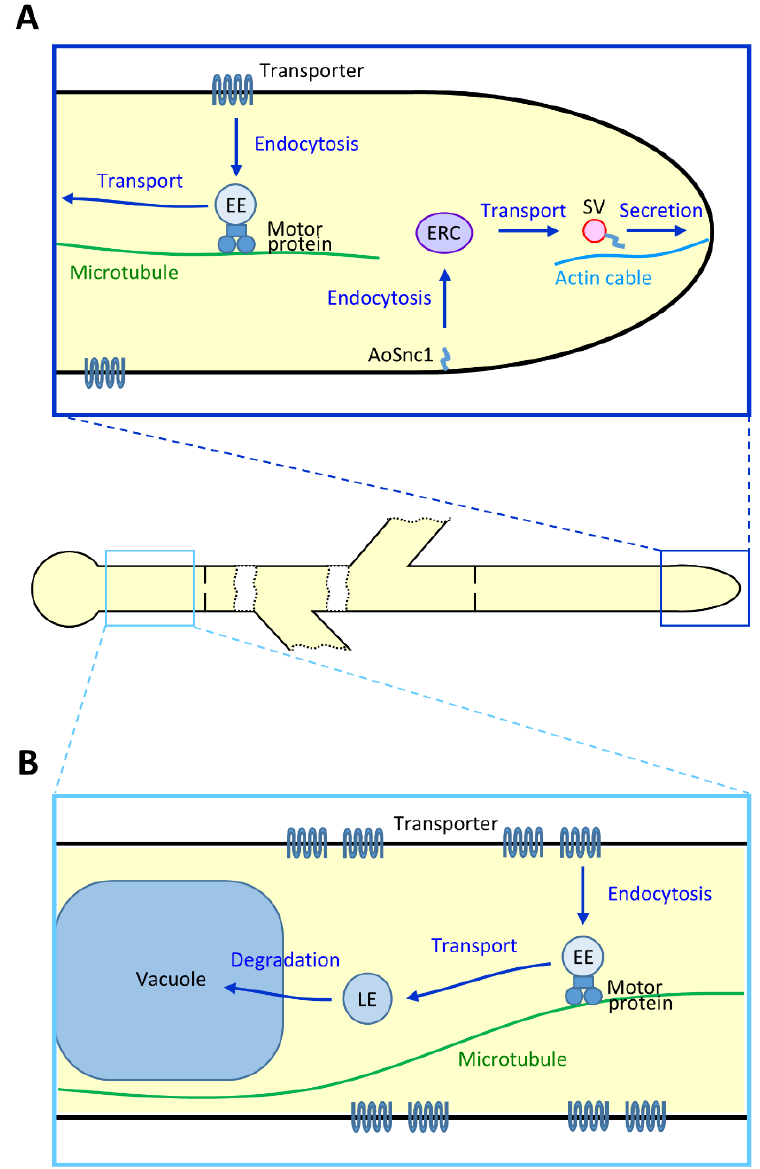
Figure 2. Endocytic pathway in A. oryzae . ( A ) Endocytic machinery at the apical region. The v-SNARE AoSnc1 is thought to be endocytosed from the plasma membrane and transported to the endocytic recycling compartment (ERC), although the existence of ERC has not been directly demonstrated in A. oryzae . Thereafter, AoSnc1 functions onto the secretory vesicle (SV). In contrast, plasma membrane transporters are endocytosed and transported through the early endosome (EE) for degradation. ( B ) Endocytosis at the basal region. Endocytosed plasma membrane transporters are transported via moving EE and relatively static late endosome (LE) and finally degraded in the vacuole.